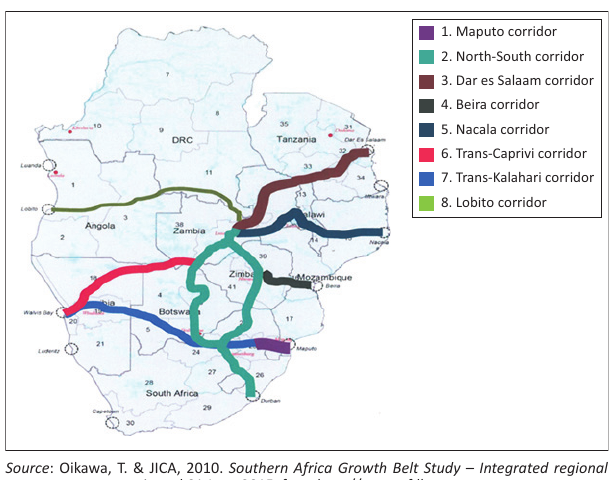
FIGURE 1: Strategic Southern African Development Community ports and corresponding